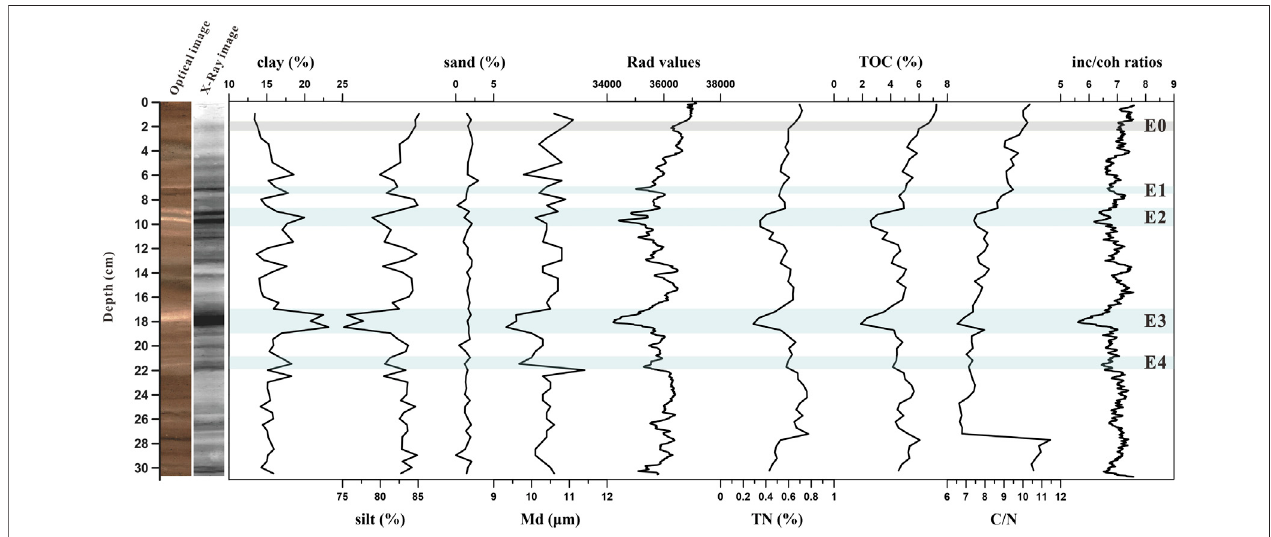
FIGURE 2 | Optical and X-radiographic images, and different proxy variations with depth in the core MGC21A. E0- fl ood event labeled as a light grey bar; E1, E2, E3, and E4- earthquake events labeled as light blue bars.